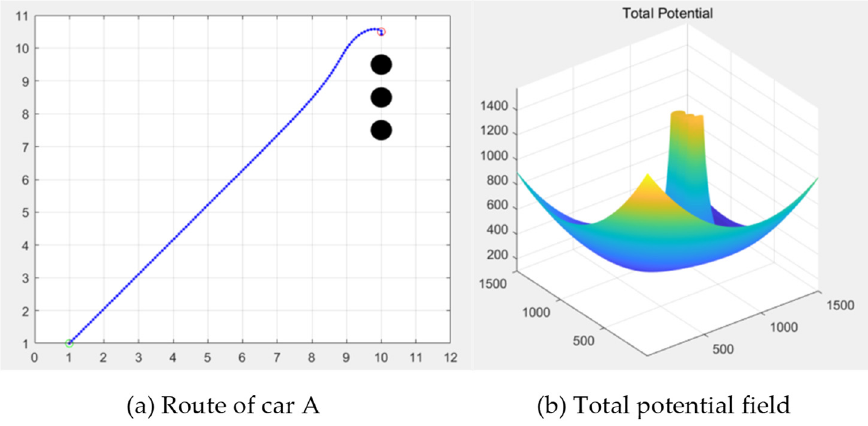
Figure 18. Single modular vehicle path under improved artificial potential field method.